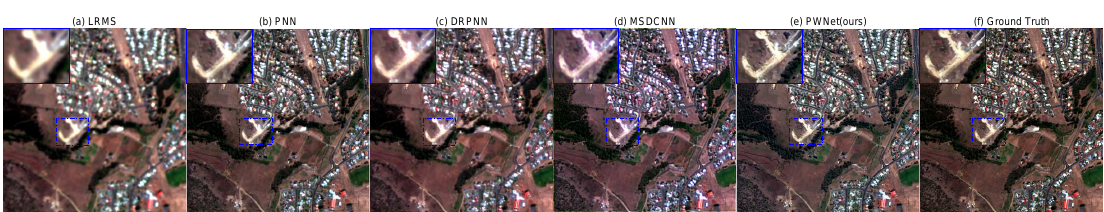
Figure 11. Visual comparison of the CNN-based methods on the WorldVie-2 data set, ( a ) LRMS; ( b ) PNN; ( c ) DRPNN; ( d ) MSDCNN; ( e ) PWNet (ours); ( f ) Ground Truth.